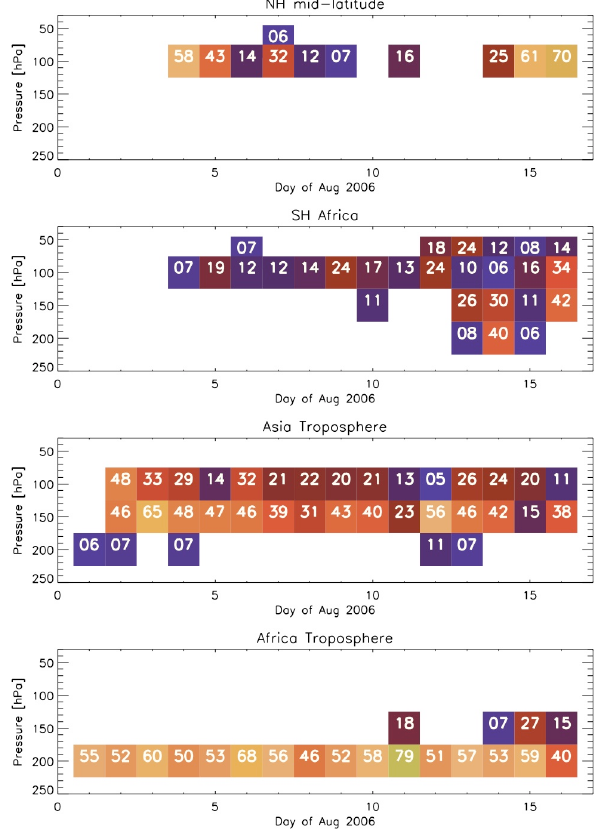
Fig. 4a. Relative contribution of different air mass origin regions (defined in Table 1) based on 10 day back trajectories to air masses arriving over the West African domain (10 ◦ E to 40 ◦ W and 5 to 25 ◦ N) between 1–16 August 2006. Colour codes the percent- age of regional influence in terms of fraction of trajectories pass- ing through a particular region (blue=low, red-orange=medium, yellow=high). This value is also expressed numerically in each coloured cell. Note that trajectories can pass through more than one region leading to total fractions of more than 100%.